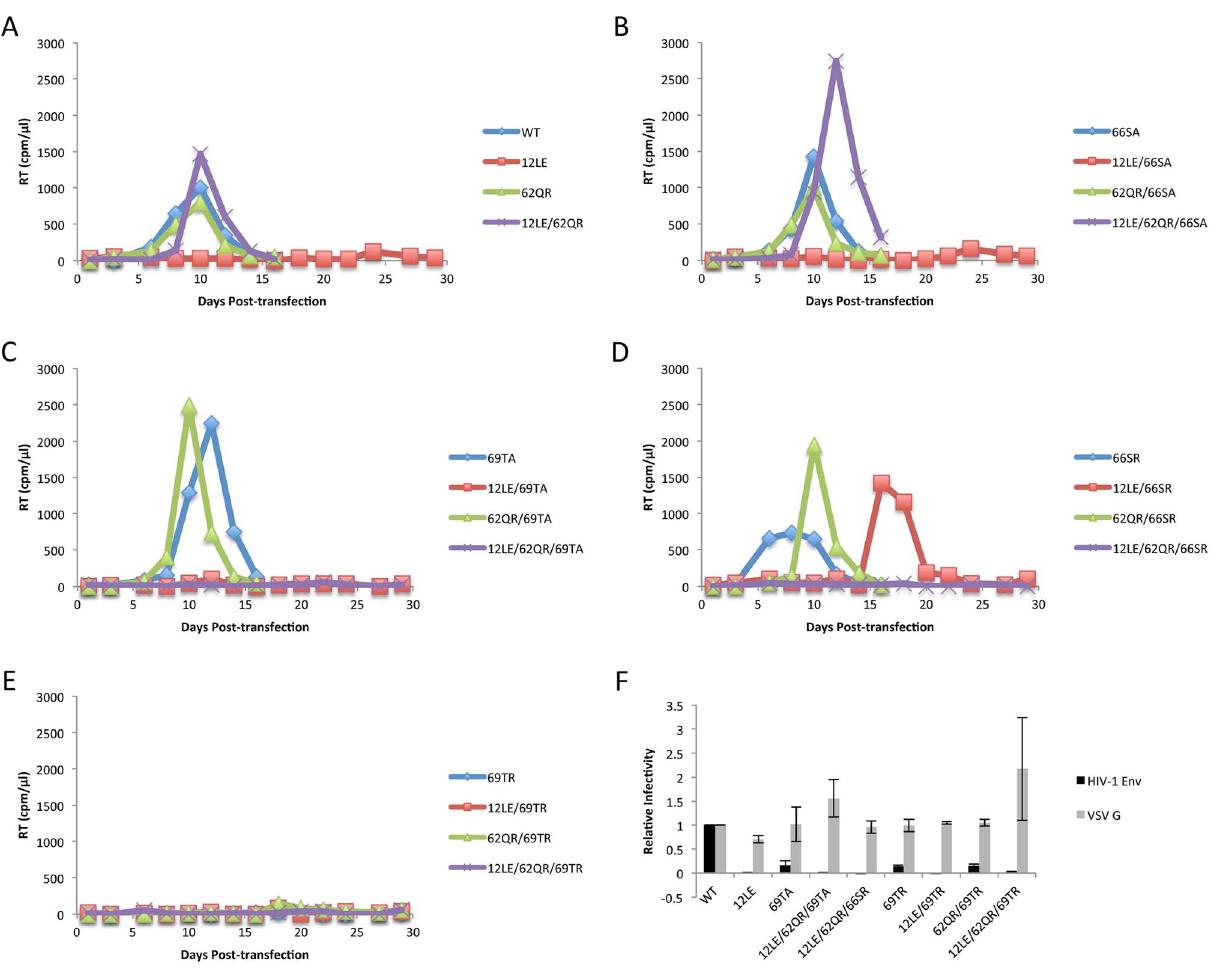
Figure 8. Replication of S66 and T69 mutants in Jurkat cells. Jurkat cells were transfected with the indicated molecular clones. At 2-day intervals the cells were split and samples of media were assayed for RT activity. In each graph of WT pNL4-3, 12LE, 62QR or 12LE/62QR mutations are combined with (A) WT; (B) 66SA; (C) 69TA; (D) 66SR; (E) 69TR. (F) 293T cells were co-transfected with the indicated molecular clones and vectors expressing HIV-1 Env or VSV-G. At 24 h, supernatants were harvested and assayed for infectivity as described in Materials and Methods. n=3, + / 2 SEM.